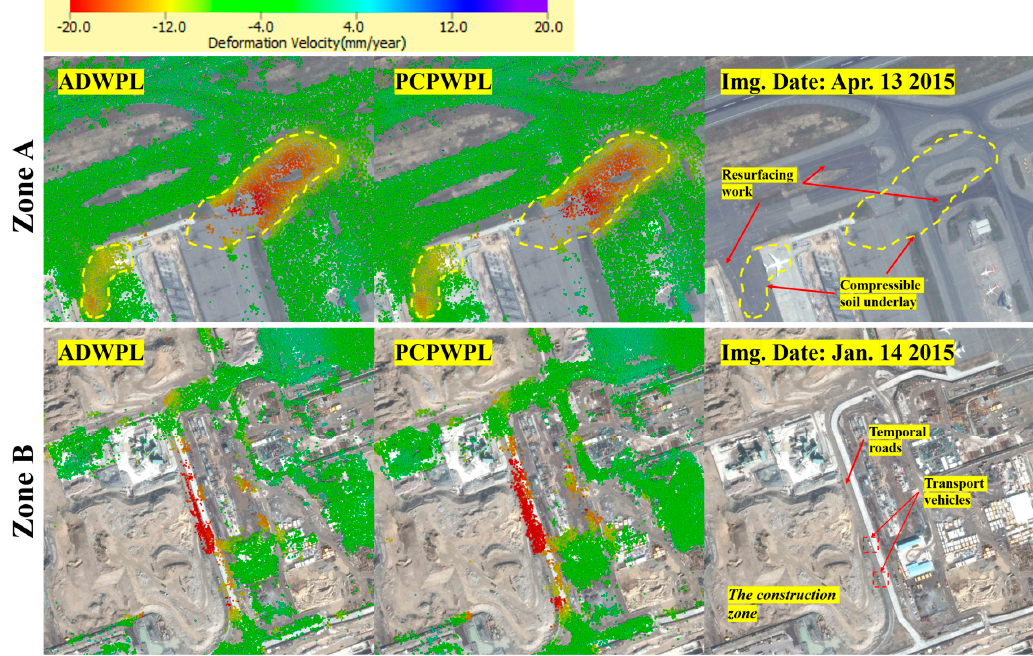
Figure 19. Subsidence in zone A: the consolidation of underlying compressible soil and zone B: the temporal transport road of the construction area.